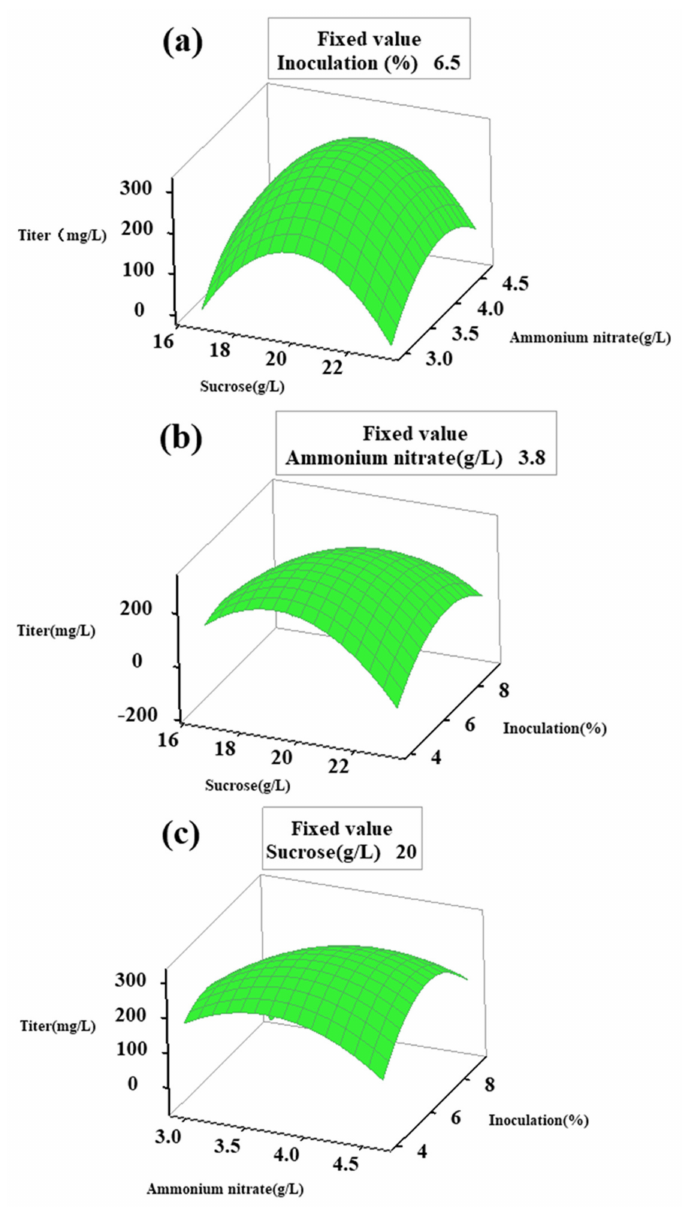
Figure 2. Three-dimensional response surface plots produced for lichenysin showing the interaction effects of sucrose, NH 4 NO 3 , and inoculum at different concentrations of the other two factors when one of them was a fixed concentration. ( a ) The interaction of sucrose and NH 4 NO 3 , ( b ) sucrose and inoculum, and ( c ) NH 4 NO 3 and